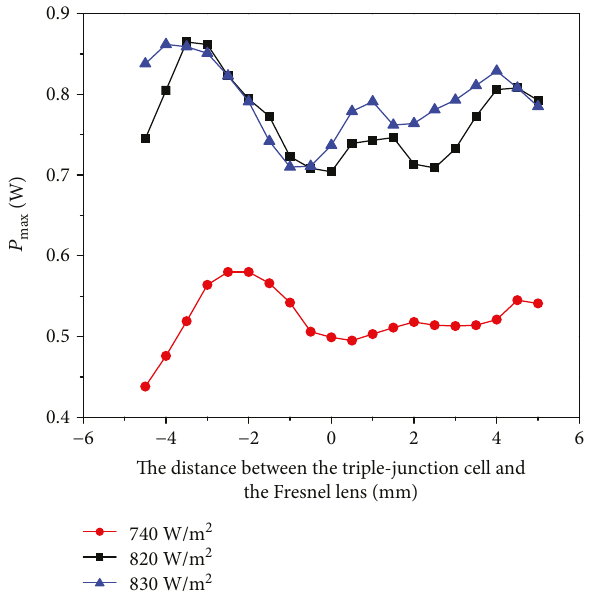
Figure 13: Changes in the maximum-output power of the triple- junction cell with the position of the optical axis.